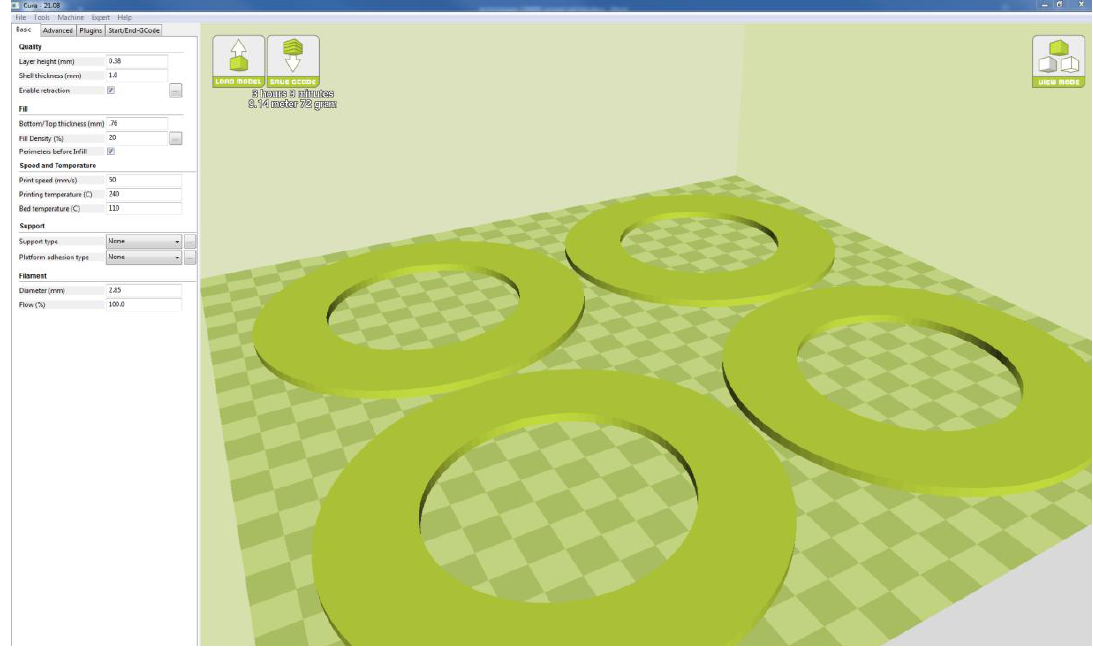
Figure 6. Standard settings for Cura using the standard settings for four 2 1/2″ oil resistant gaskets.